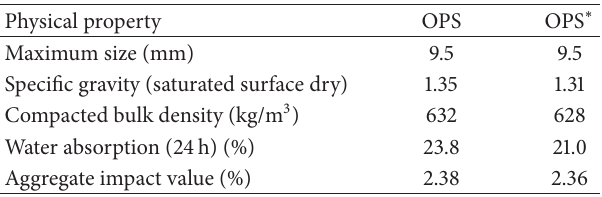
Table 2: Physical properties of crushed-heat treatment dura OPS